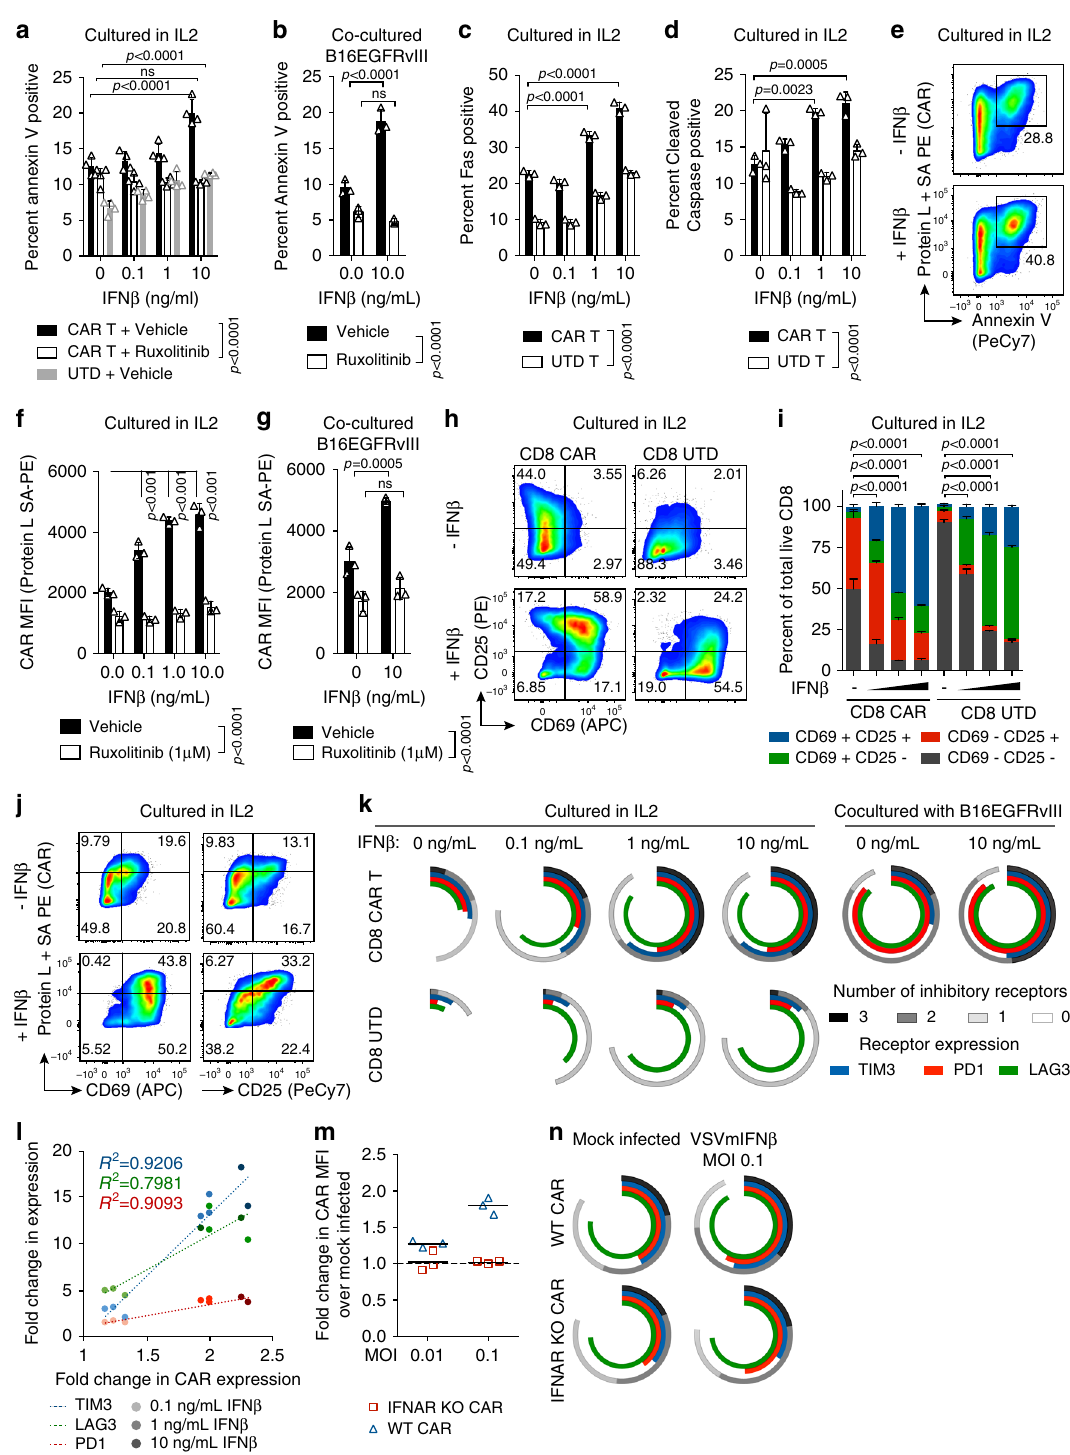
expression and generated CAR + IFNAR1 – CD8 and CD4 popu- lations with approximately 92 and 85% ef fi ciency, respectively (Fig. 6a). CRISPR modi fi ed CAR T cells were functionally insen- sitive to the deleterious effects of recombinant IFN β , and did not upregulate the CAR, Fas, or inhibitory receptors (Fig. 6b – d). As IFNAR1 KO CAR T cells were at least partially resistant to the VSVmIFN β induced attrition in vivo, and were also resistant to CAR expression dysregulation in vitro, we hypothesized that these type I IFN insensitive transgenic CAR T cells would provide